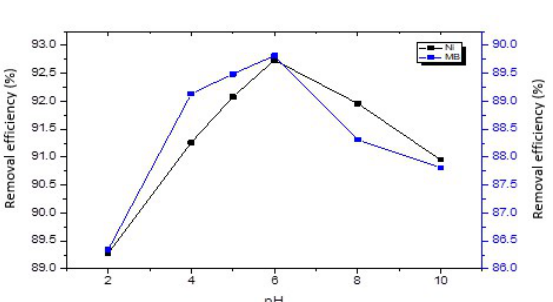
Fig.4. Infrared spectra of natural clay